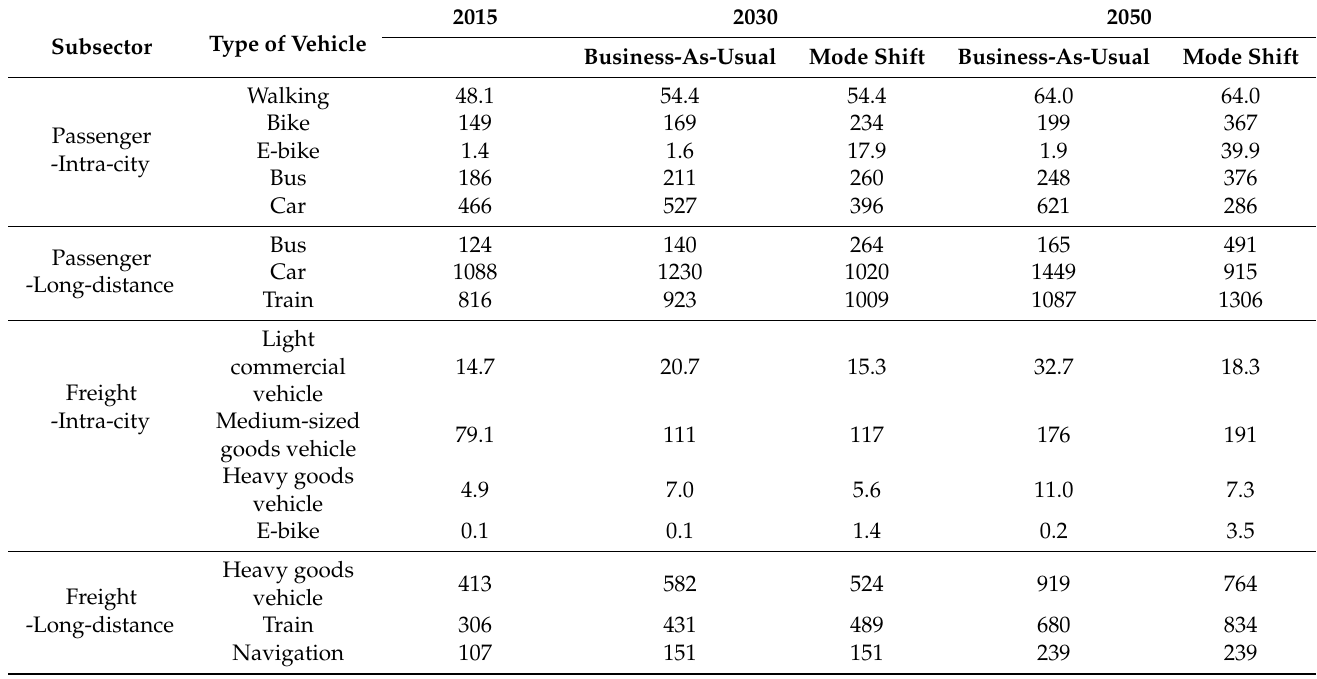
Table A3. Transport demand input data given in pkm or tkm